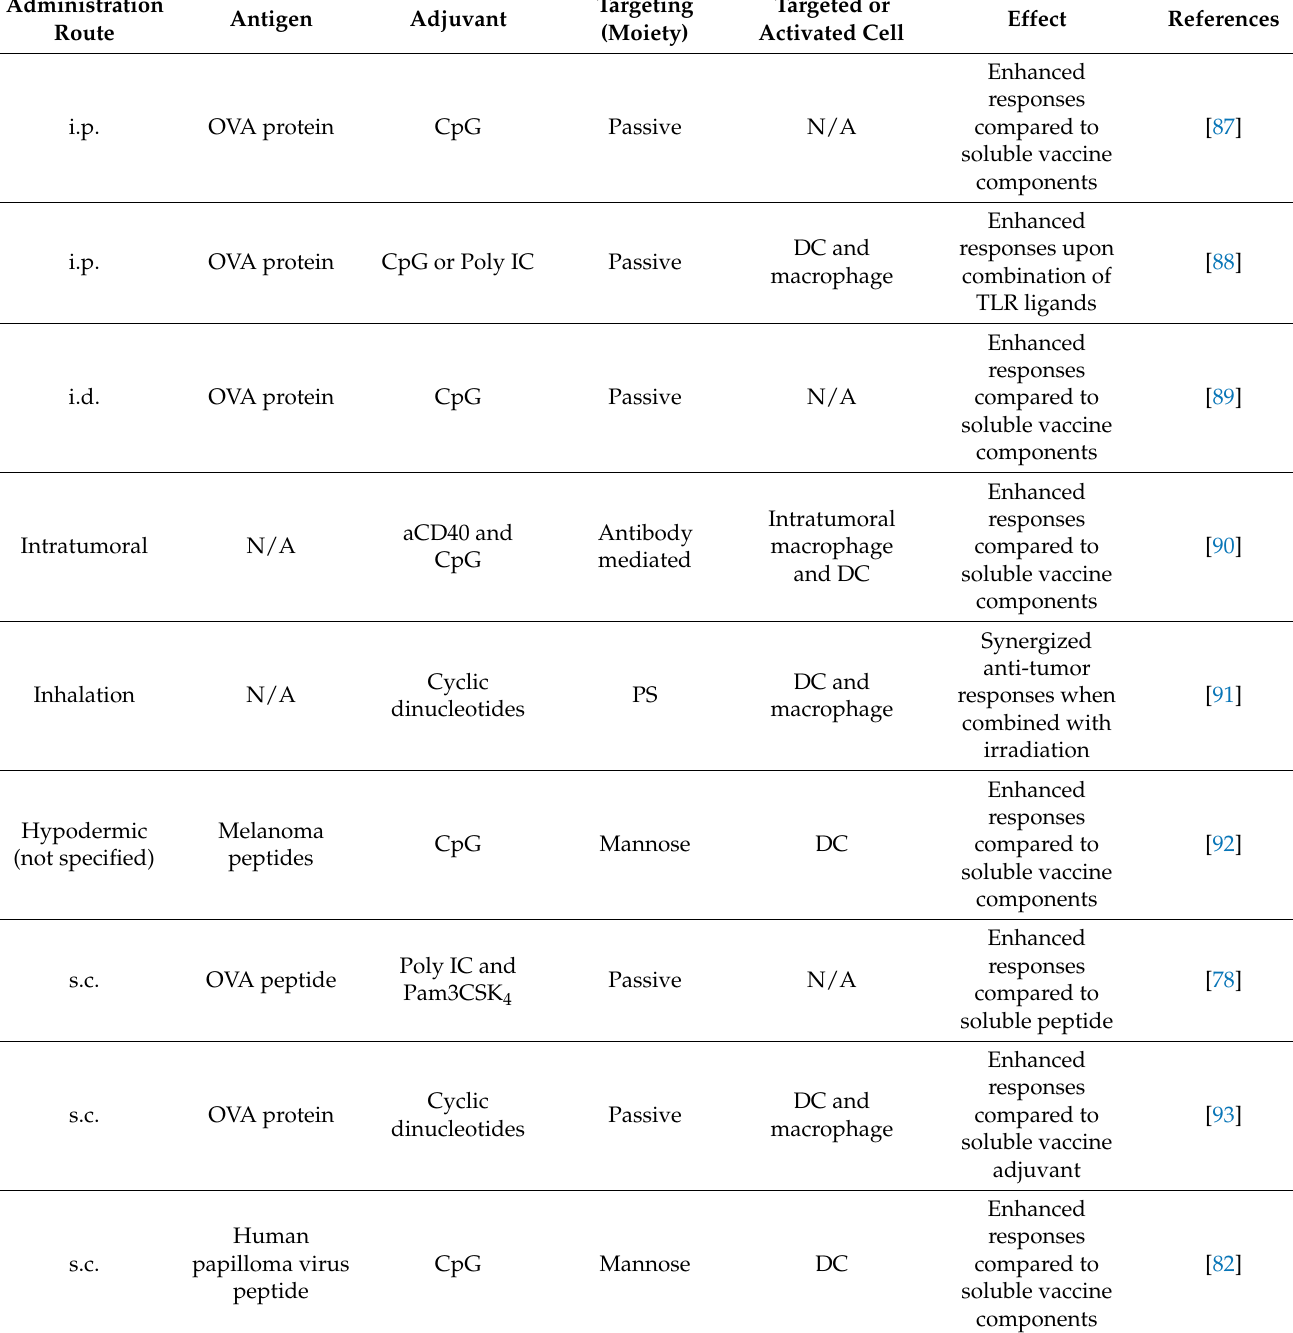
Table 2. Liposomal encapsulation of antigen and adjuvant as well as surface modification with targeting moieties augments vaccine potency in